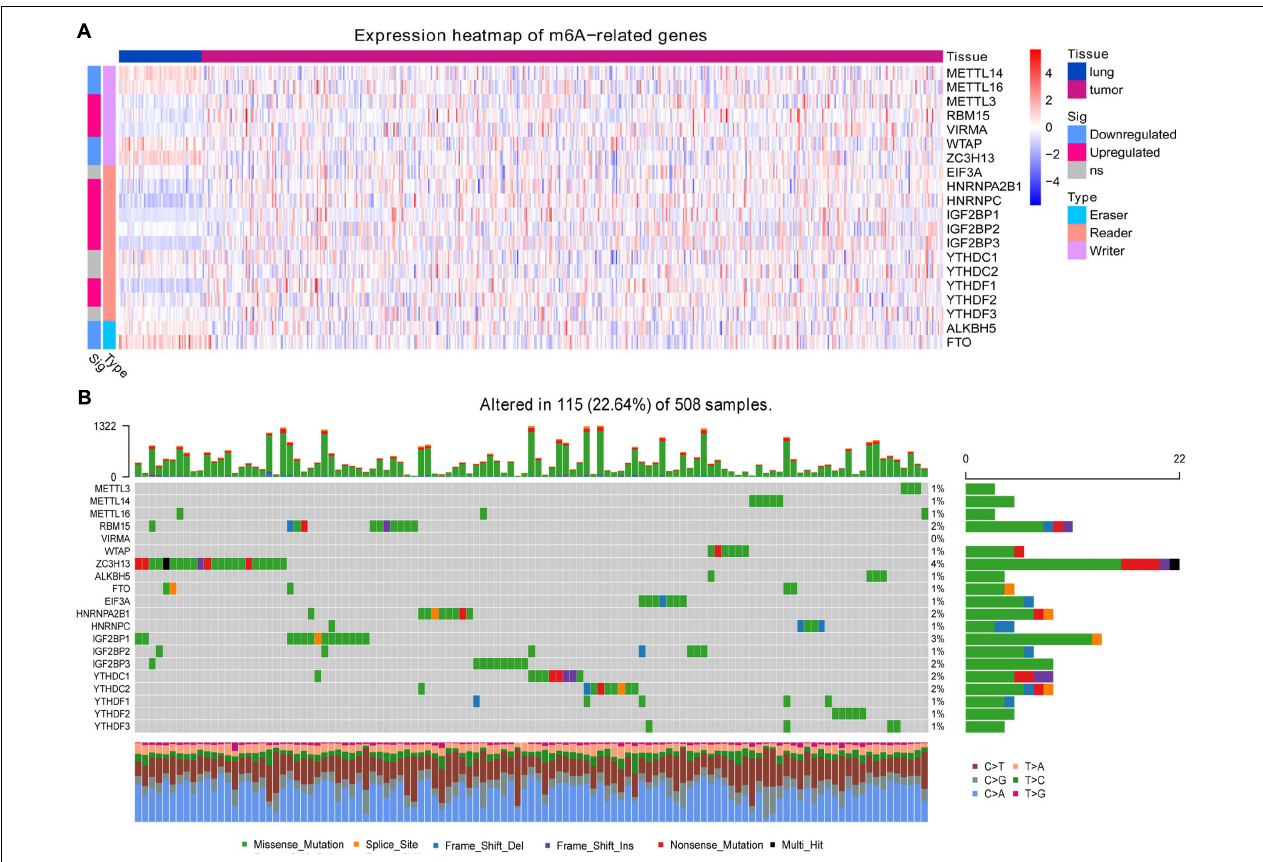
FIGURE 1 | Expression and mutation status of 20 m6A-related genes. (A) Differential gene expression between lung adenocarcinoma and healthy lung tissue. (B) Mutation status of the genes in lung